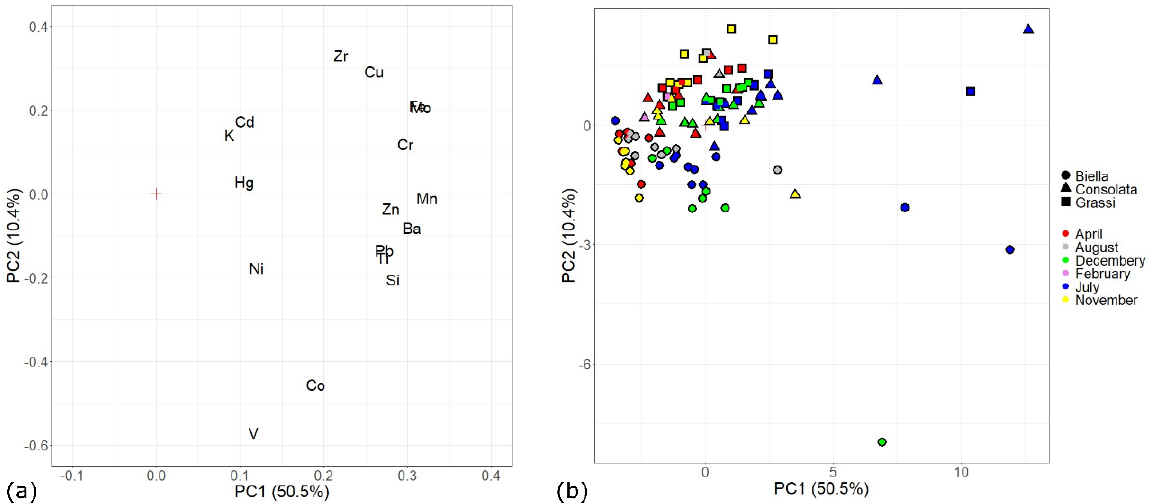
Figure 7. Loading and score plots for PC1 and PC2. The chemometric treatment was performed on data expressed as metals mass amounts per unit of mass of PM 10 (mg g − 1 ). ( a ) Loading plot; ( b ) Score plot.